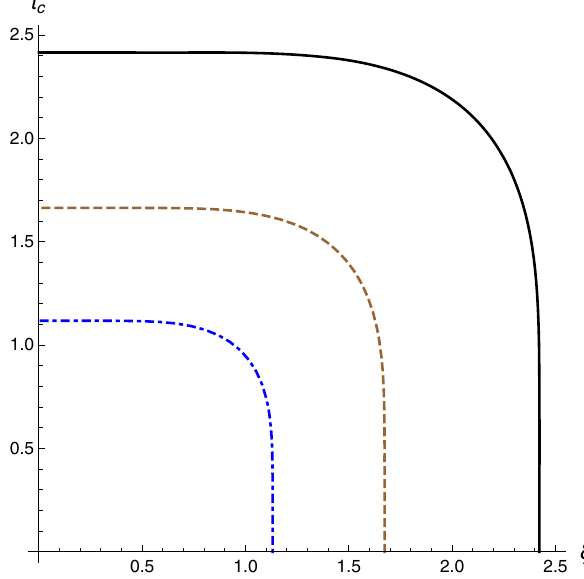
Fig. 3 Reduced transition temperature as a function of the reduced inverse size, for fixed γ = 0 . 3 and δ = 5 . 0, and distinct values of the quartic self-coupling: λ = 0 . 5; 1 . 0; and 2 . 0, full , dashed and dotdashed lines ,